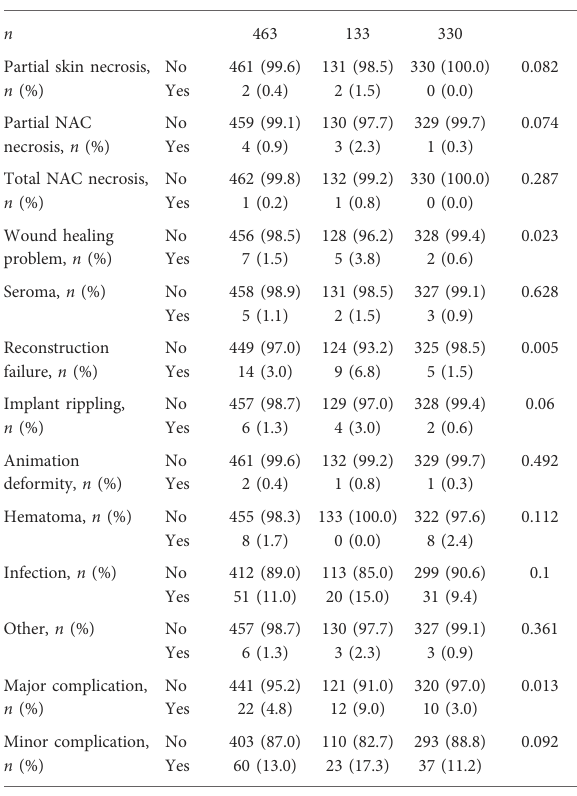
TABLE 4 Complication by mastectomy type ( N =463). Level